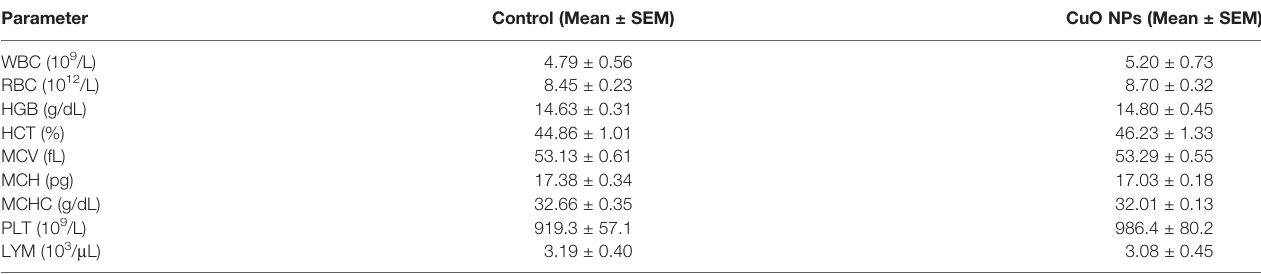
TABLE 3 | Hematological parameters in mice after 6-week inhalation of CuO NPs.